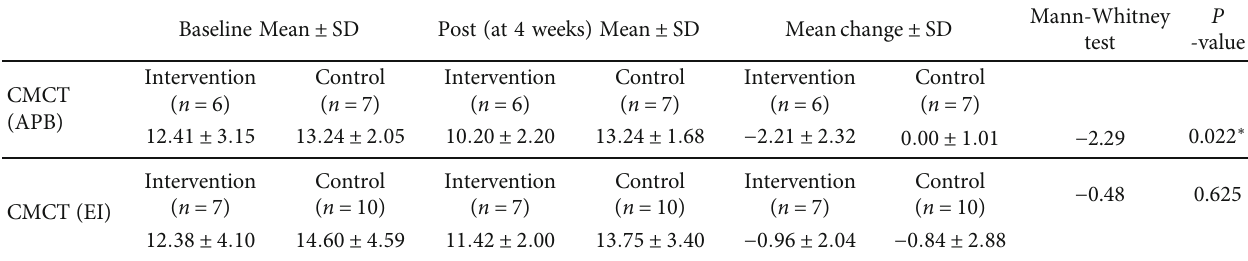
Table 4: MEP comparison between the intervention and control groups, before and after the therapy. Baseline Mean ± SD Post (at 4 weeks) Mean ±